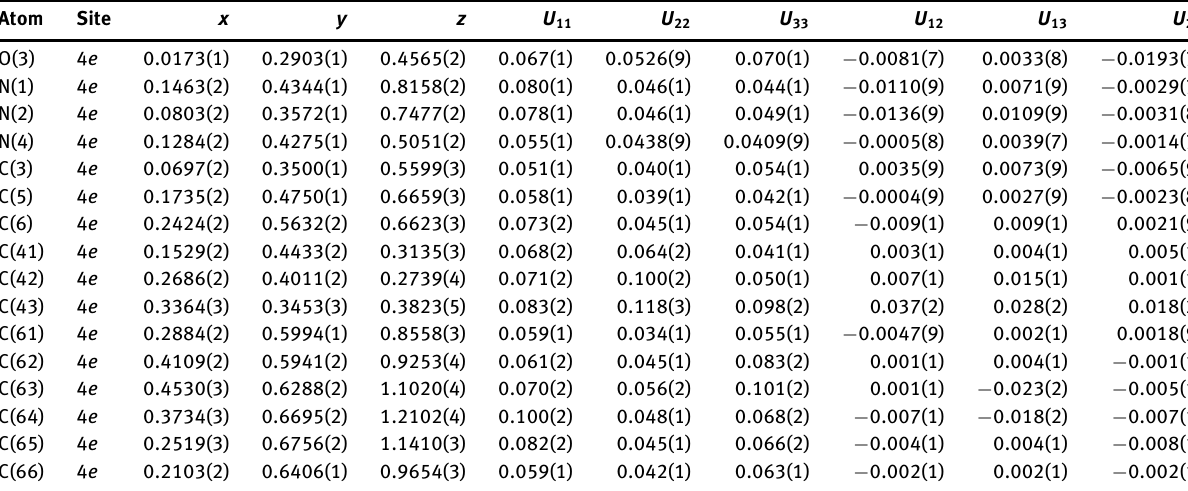
Table 3: Atomic displacement parameters (Å 2